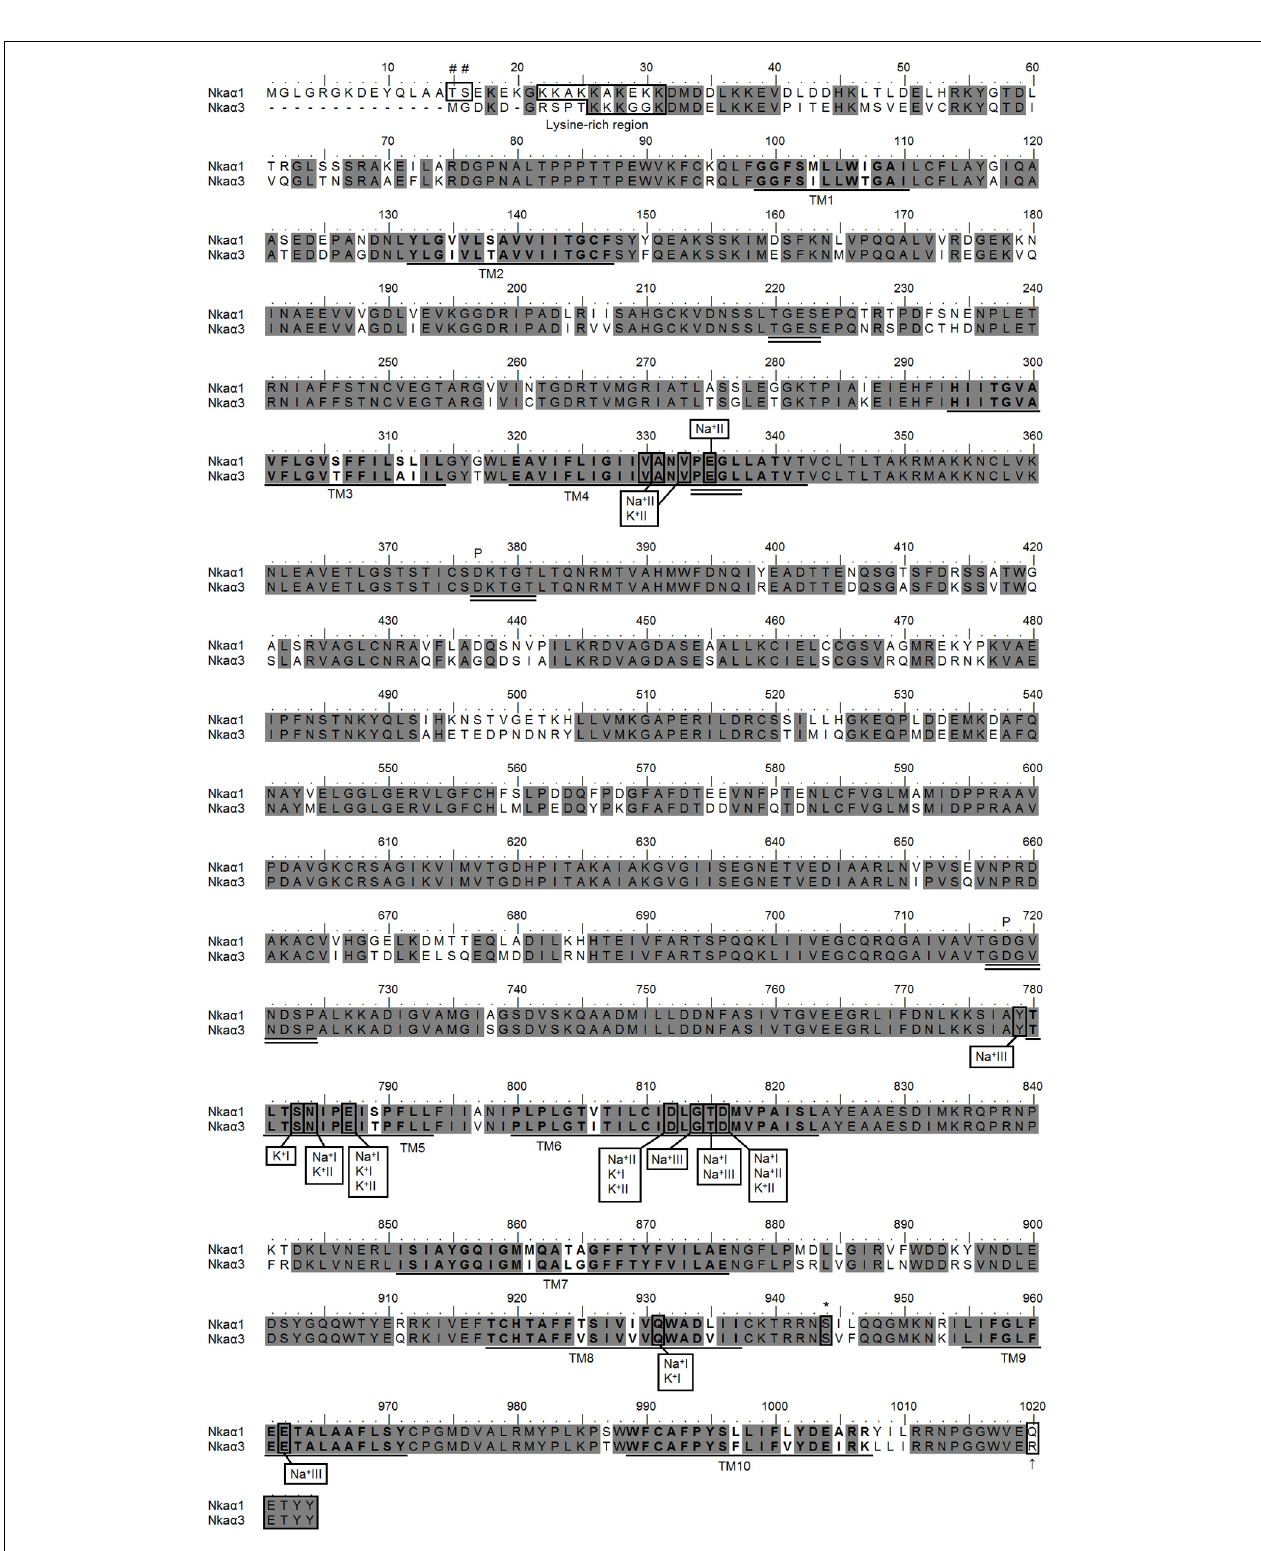
shaded dark gray residues. The 10 predicted transmembrane regions (TM1-TM10) are underlined and in bold. Vertical boxes represent coordinating